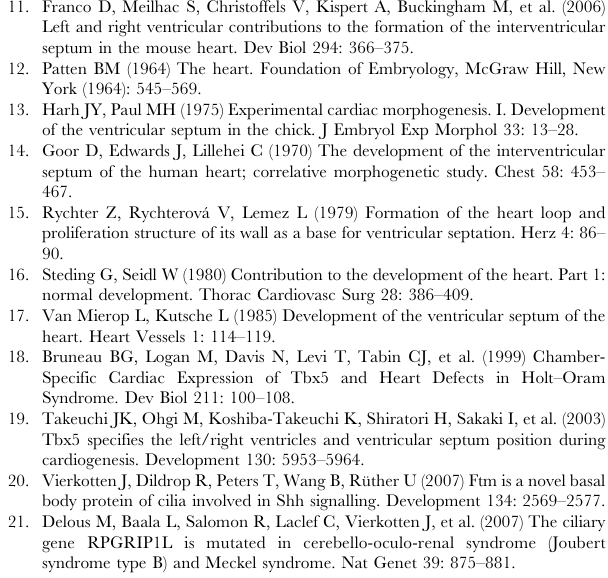
Figure S5 Apoptosis at E11.5 and proliferation rate at E14.5 is unaltered in Ftm -deficient hearts. (A) Apoptosis studies by TUNEL stainings in E11.5 hearts. No significant differences can be detected in wild-type (n =3), Ftm -heterozygous mutant (n= 3) and Ftm -homozygous mutant (n= 3) heart com- partments. (B) Proliferation rate is determined by the relation of dividing (BrdU-marked) cells to the number of all cells in distinct heart regions at E14.5 ( Ftm + / + : n =3 hearts; Ftm 2 / 2 : n =3 hearts). In none of the investigated Ftm -negative heart compartments, cell proliferation is significantly altered. Figure S6 Expression alterations of genes involved in cell cycle progression and proliferation in atria and ventricles. Semi-quantitative PCR analysis of wild-type and Ftm 2 / 2 atrial and ventricular tissue at E11.5. Hprt serves as loading control. Expression of cyclin E is downregulated and expression of p27 is upregulated in Ftm -negative atria and ventricles suggesting a disturbance in cell cycle progression and proliferation. Figure S7 Gli3-190 localizes at the base of ventricular cilia. Immunohistochemistry on transverse heart sections at E11.5. (A) Centrosomes/basal bodies are marked in green by c - tubulin and cell nuclei in blue by DAPI. Scale bar (in white) represents a length of 2 m m. Gli3-190 staining (red) partially overlaps with the staining of the centrosome/basal body (green). (B) Pericentriolar material at the base of cilia is stained in blue by pericentrin and the ciliary axoneme in green by acetylated a - tubulin. Gli3-190 (red staining) co-localizes with pericentrin and hence is present at the base of ventricular cilia. Figure S8 pMek1/2, a Pdgfr a signaling pathway com- ponent, is downregulated in Shh -negative ventricles. Western blot analysis of E11.5 ventricular protein lysates. Gapdh serves as loading control. In Shh -negative ventricles (n= 3), there is less phosphorylated Mek1/2 protein than in wild-type littermates.